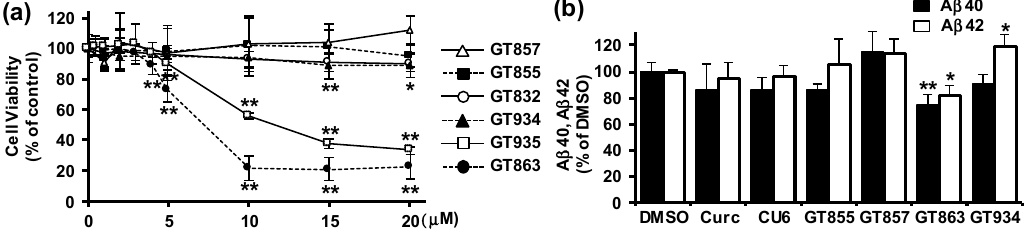
Figure 1. Screening of curcumin derivatives for effect on A β production in Chinese hamster ovary–amyloid- β precursor protein (CHO-APP) cells. ( a ) CHO-APP cells were treated with different concentrations of curcumin derivatives for 24 h. Cell viability was measured by 2-(2-methoxy-4- nitrophenyl)-3-(4-nitrophenyl)-5-(2,4-disulfophenyl)-2H-tetrazolium (WST-8) assay. n = 3. * p < 0.05, ** p < 0.01. ( b ) CHO-APP cells were treated with 10 μ M curcumin, CU6, GT855, GT857, or GT934, or with 3 μ M GT863, for 24 h. Secreted A β 40 or A β 42 in conditioned media was measured by ELISA. n